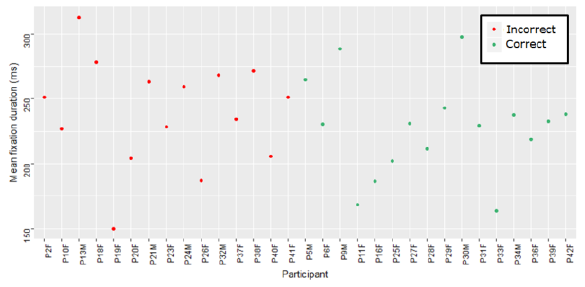
Figure 6. Average fixation duration for each participant for anterolateral STEMI ECG by